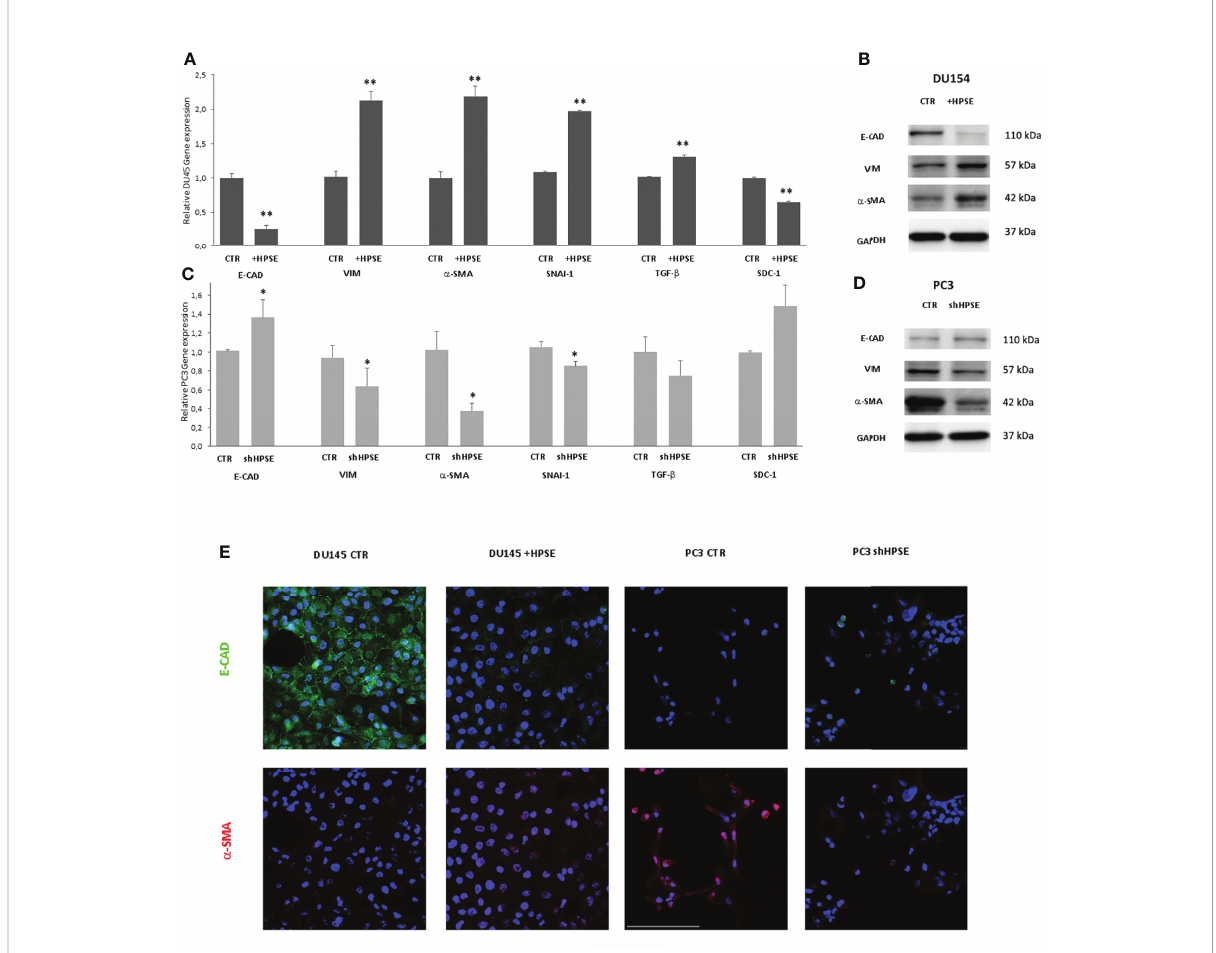
FIGURE 2 EMT markers expression in prostate cancer cells. E-CAD, VIM, a -SMA, TGF- b , and SDC-1 gene expression was evaluated by real-time PCR in DU145 (A) and PC3 (C) cells. Data were normalized to GAPDH expression. Means ± SD (error bars), n=6. **p < 0.001, *p<0.05 vs. CTR. E-CAD, VIM, a-SMA, and protein level were quanti fi ed by WB in DU145 (B) and PC3 (D) cells. GAPDH was included as loading control. (E) E-CAD (green) and a -SMA (red) immuno fl uorescence in DU145 and PC3 cells. Nuclei were counterstained with Hoechst 33342. Scale bar = 100 m